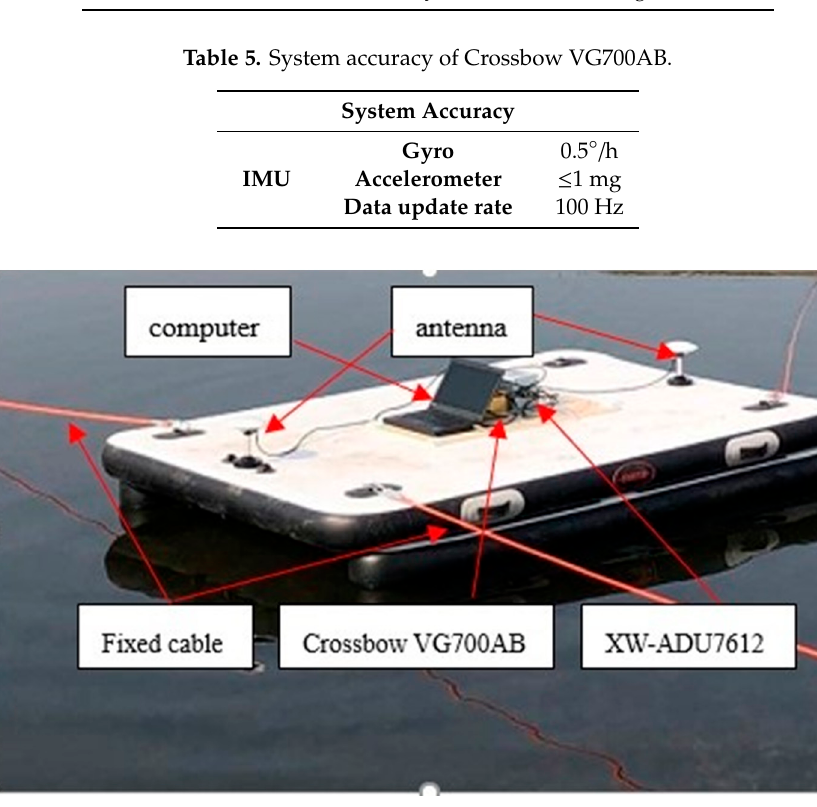
Figure 5. Installation diagram of the experimental